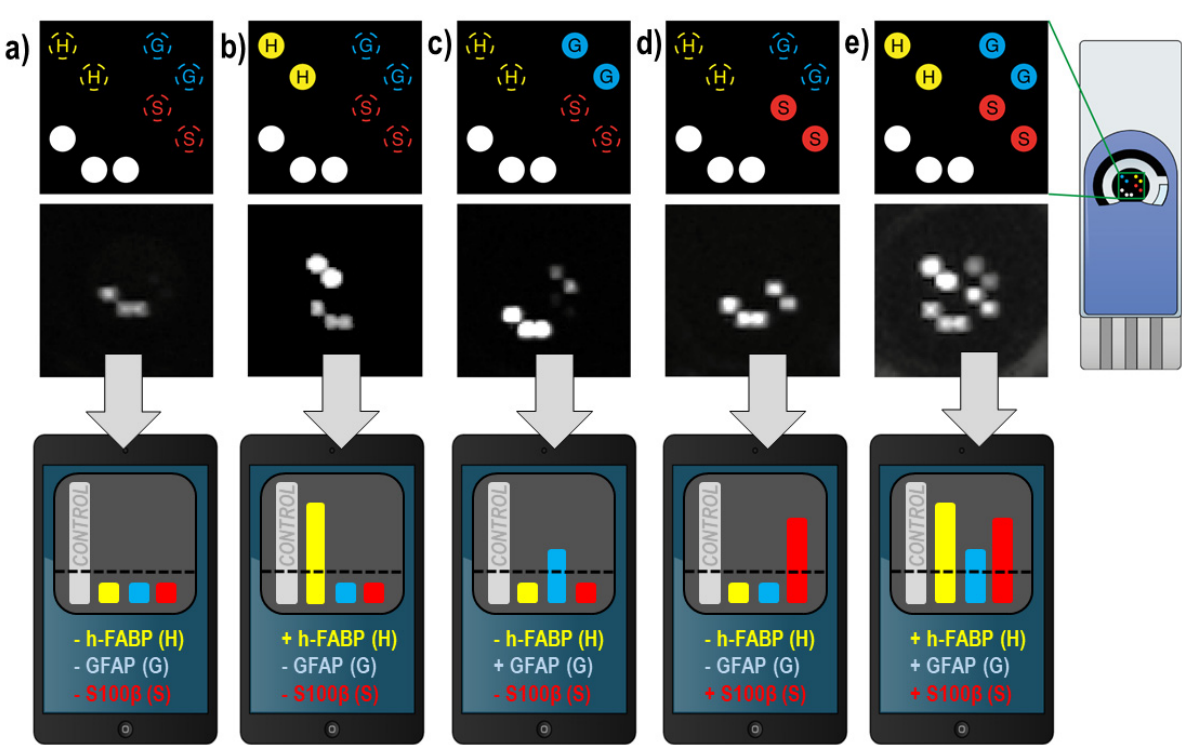
Figure 5. Multiplex ECL detection of mTBI biomarker panel established on a single SPCE. Top panel figures indicate the electrode patterns that contain alignment spots (“control”) made with BSA protein labelled with SULFO-TAG (white spots); spots for GFAP biomarker (blue spots with letter “G” indicate the position of GFAP capture antibodies); spots for h-FABP biomarker (yellow spots with letter “H” indicate the position of h-FABP capture antibodies); and spots for S100 β biomarker (red spots with letter “S” indicate the position of S100 β capture antibodies). Dashed letter spots indicate that no antigen was added (blank), while full-colored letter spots indicate that respective antigen was added in the assay. Middle panel figures respectively show real ECL images obtained from the electrode pattern indicated on top panel images, and bottom panel figures show the concept of the signal read-out displayed for the future envisioned mTBI POC diagnostic device: ( a ) biomarkers not detected in the sample (only three “control” spots are visible); ( b ) h-FABP biomarker detected; ( c ) GFAP biomarker detected; ( d ) S100 β biomarker detected; ( e ) all three biomarkers detected.